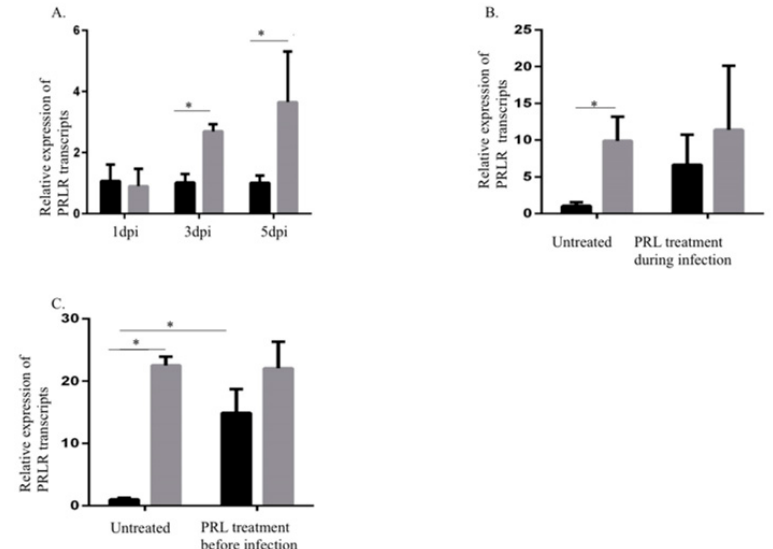
Figure 2. Increased prolactin receptor (PRLR) transcript levels in HCMV-infected SKOV3 cells. ( A ) Relative expression of PRLR in SKOV3 cells infected with HCMV (MOI 5) compared to noninfected cells was determined by qPCR at 1, 3, and 5 dpi. ( B , C ) Relative expression of PRLR in SKOV3 uninfected cells or infected with HCMV (MOI 5) after pretreatment or at the same time as treatment with PRL (200 ng / mL) was determined by qPCR at 3 dpi. Data is presented as mean ± SD ( n = 3). Statistical significance is indicated as * P <